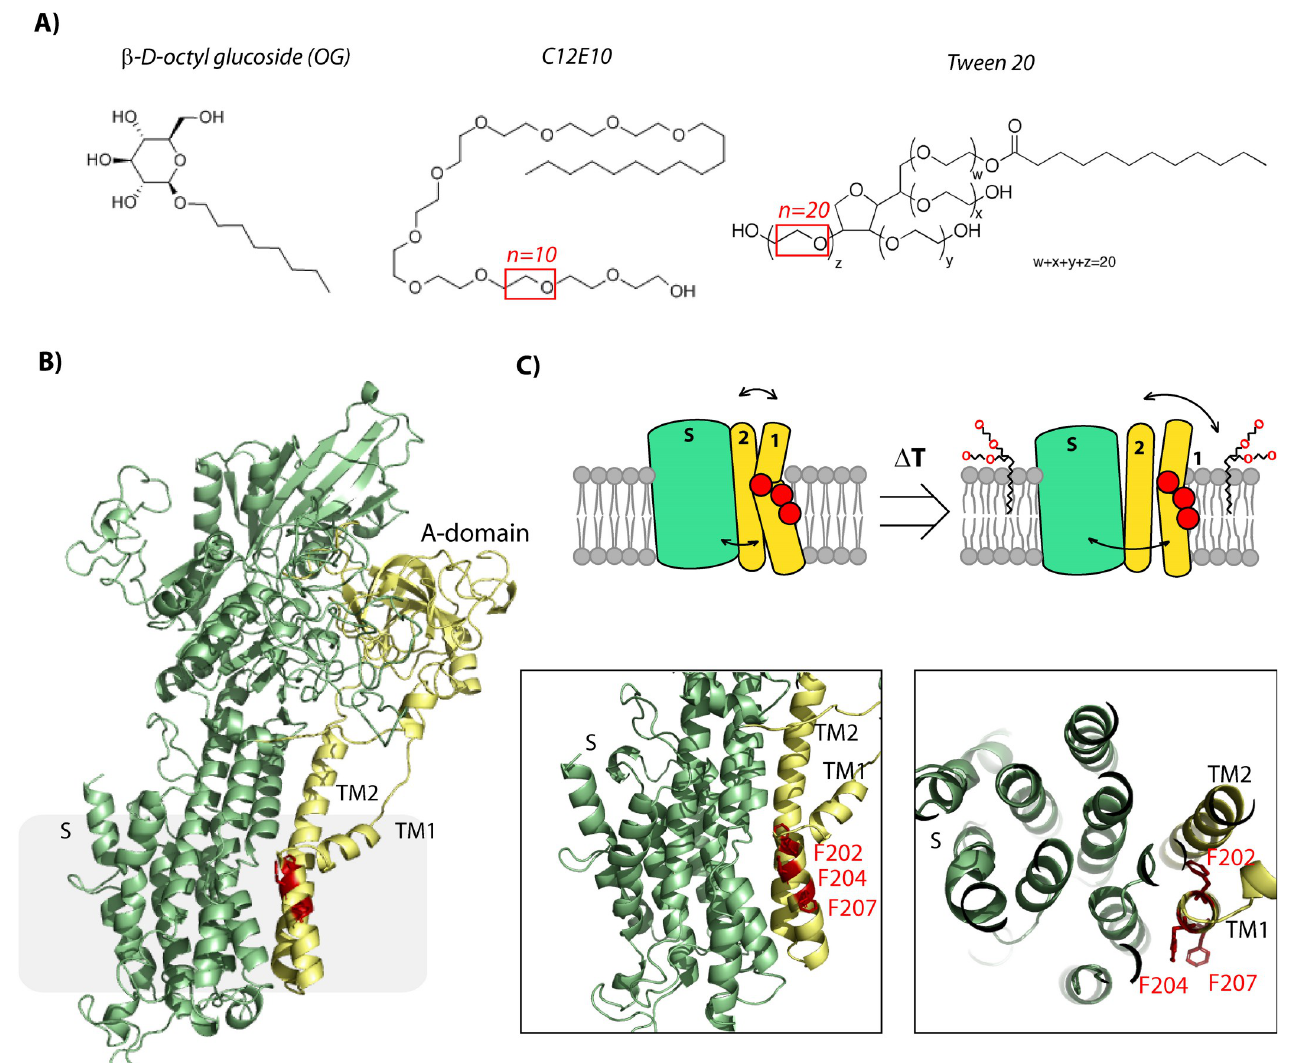
Fig 7. Schematic overview of detergents and Spf1p. A) Detergent structures with the amount of mono glycol ethers in each detergent indicated in red. B) Homology model of the Spf1p structure based on the apo state of the Ca 2+ ATPase showing location of the conserved phenylalanines in M1 in red, M1-2 and the A domain in yellow and the remainder of the protein (S-domain) in green. Closeup of the M1 helix show location of the phenylalanines which are comparable to the recently published apo structure of Spf1p [13]. C) Schematic overview of the phenylalanines (red dots), M1-2, A-domain (yellow) and M3-10 and S-domain (green) in the absence and presence of polyethylene containing detergents